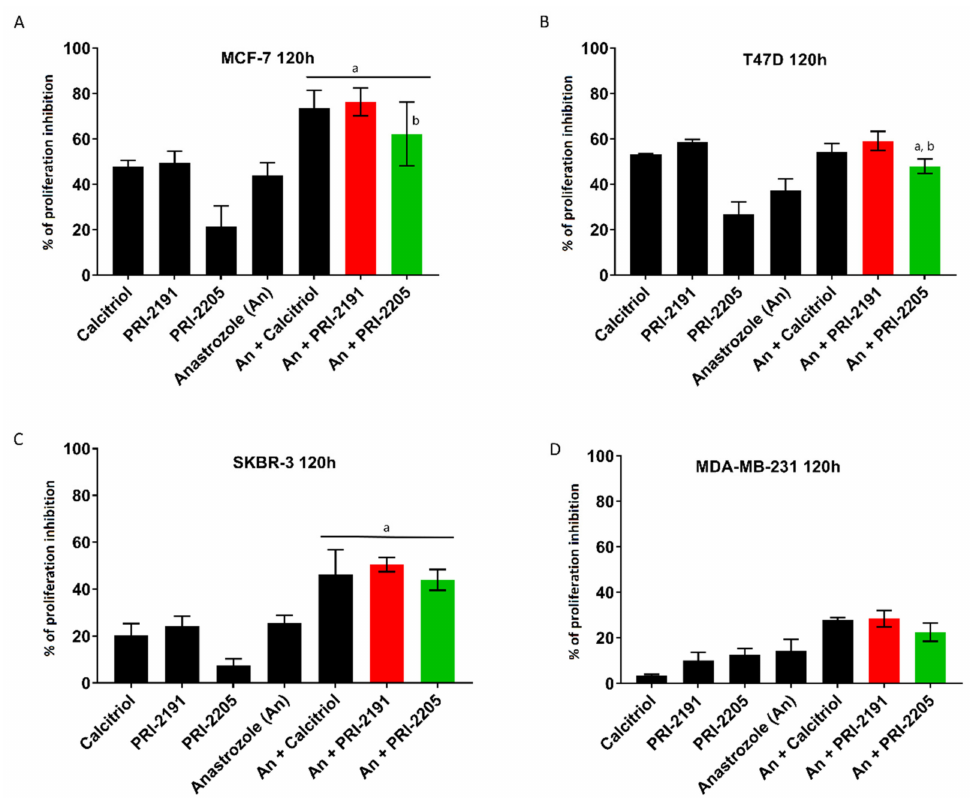
Figure 2. The proliferation inhibition ( A – D ) of human breast cancer cell lines after treatment with analogs of 1,25(OH) 2 D 3 alone or in combination with anastrozole. As indicated ( A ) MCF-7 cell line, ( B ) T47D cell line, ( C ) SKBR-3 cell line, and ( D ) MDA-MB-231 cell line after 120 h of treatment with calcitriol or PRI-2191 and PRI-2205 and anastrozole. Calcitriol and PRI-2191 and PRI-2005 were used at the dose of 100 nM ( A , C , D ) or 10 nM ( B ). Anastrozole was used at the dose of 0.1 mg/mL. The tests were performed 3 to 6 times, each in triplicate. The % (mean ± SD) of proliferation inhibition of cancer cells is shown on the graphs. The nonparametric Kruskal-Wallis ANOVA for multiple comparisons was performed. p < 0.05 was considered to be statistically significant; a—compared to anastrozole, b—compared to PRI-2205